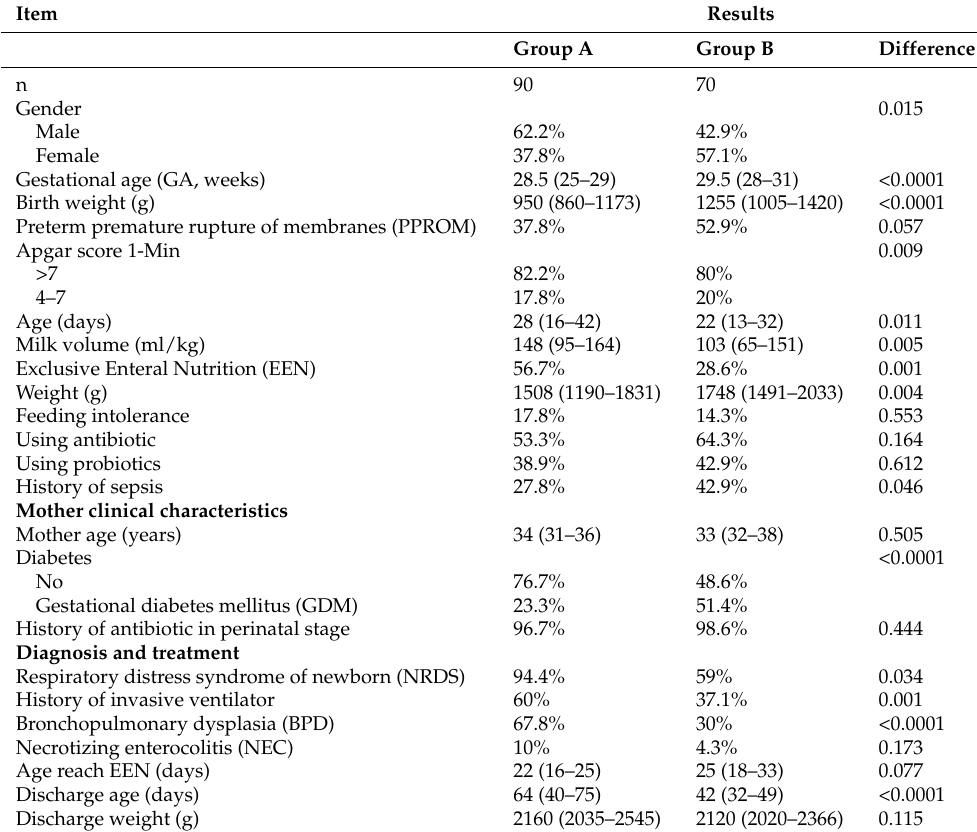
Table 1. Preterm infants’ clinical